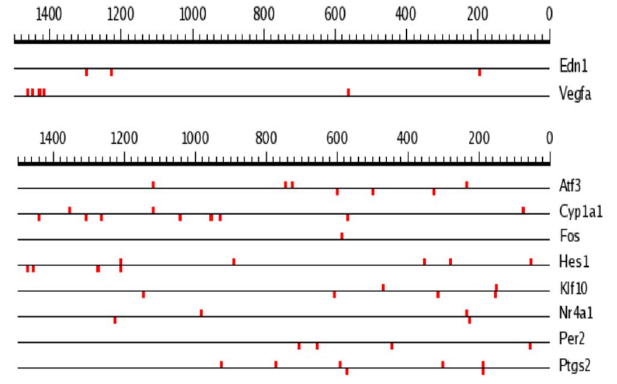
Figure 8. Position of (A/G)CGTG consensus within 10,000 bp 5 9 -UTR of genes listed in Table 5.